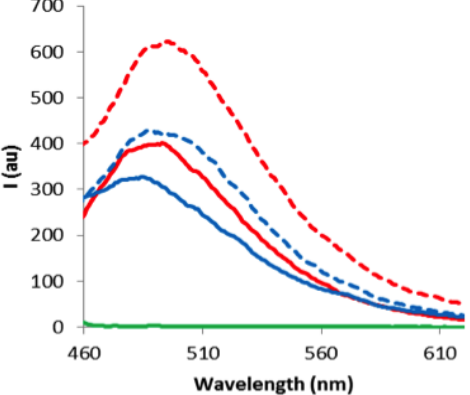
Figure 3. Fluorescence emission spectra ( λ ds ODN3 ; blue: ss ODN5 and doted blue: ds ODN5 .